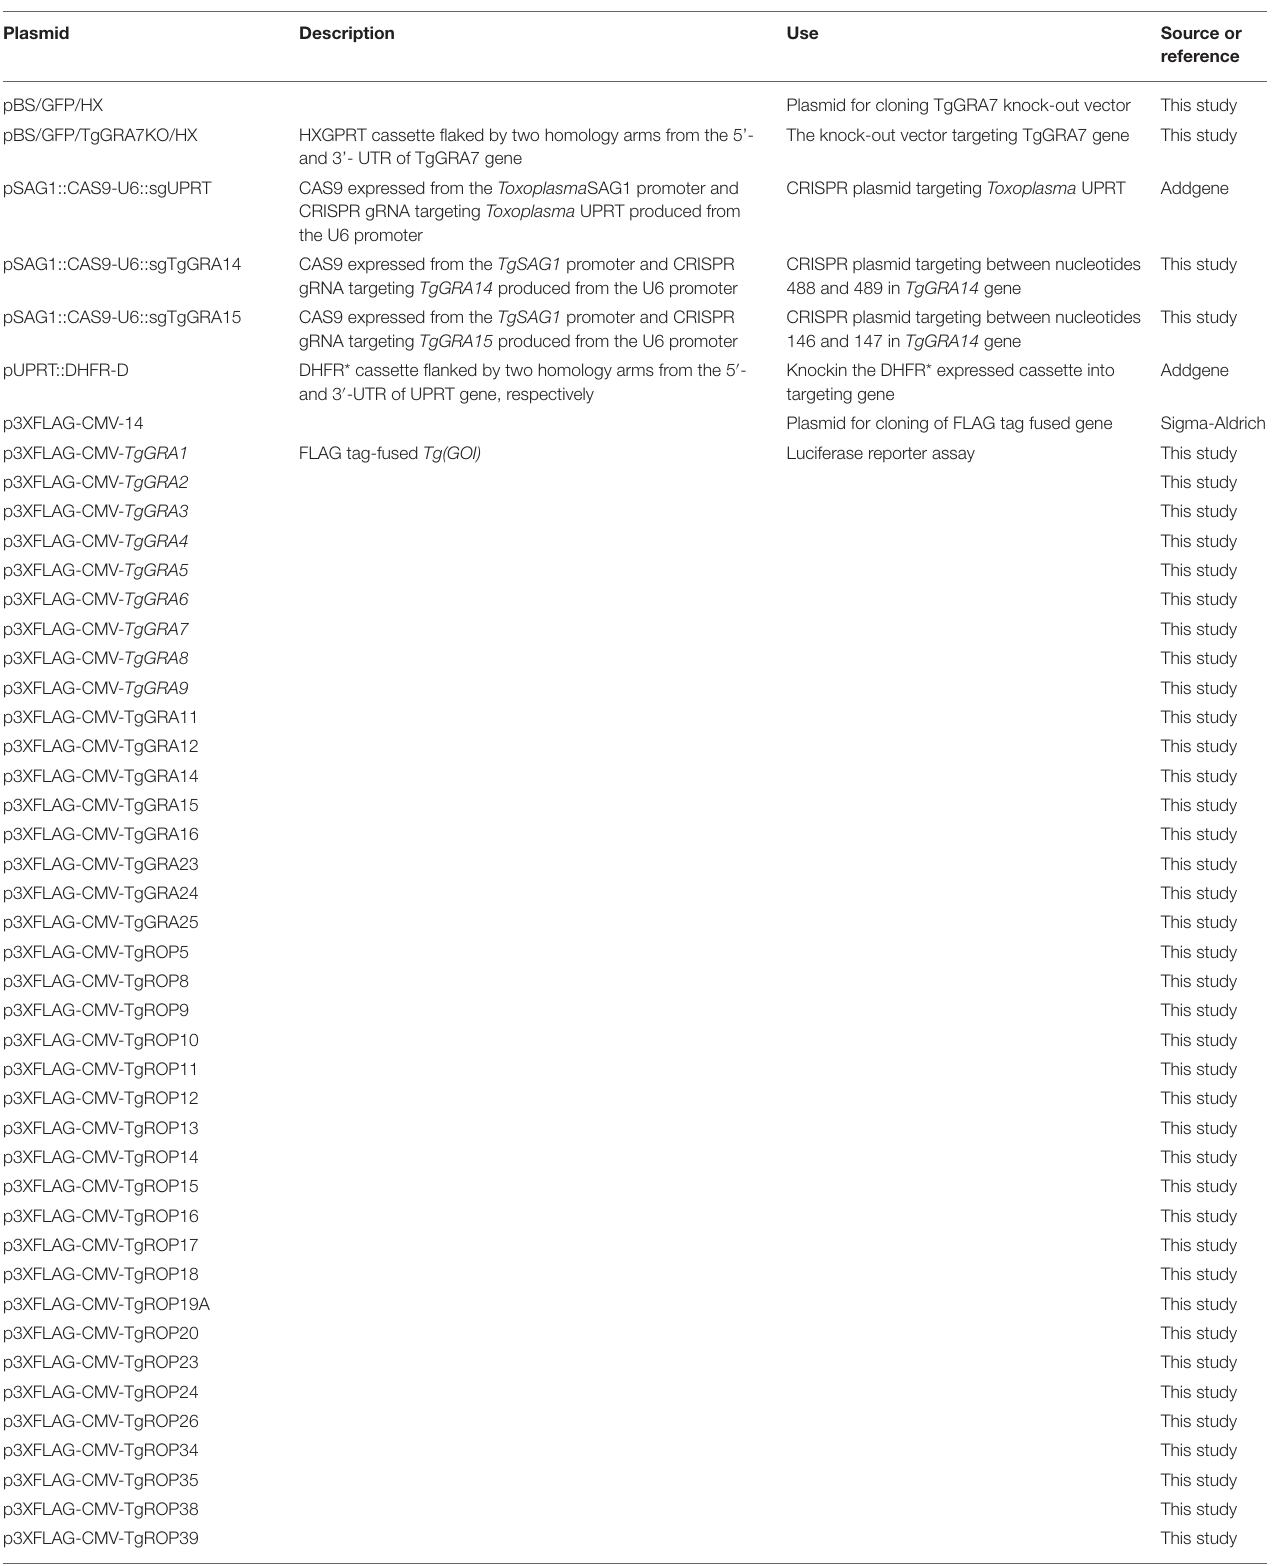
TABLE 1 | Plasmids used in this